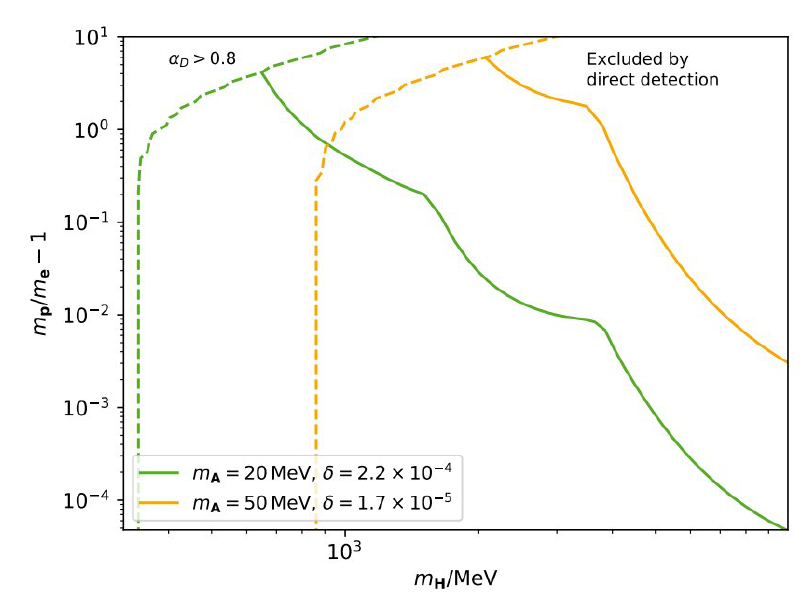
from direct detection of dark atoms in a H (cid:48) = 0.1 of ionized millicharged dark i